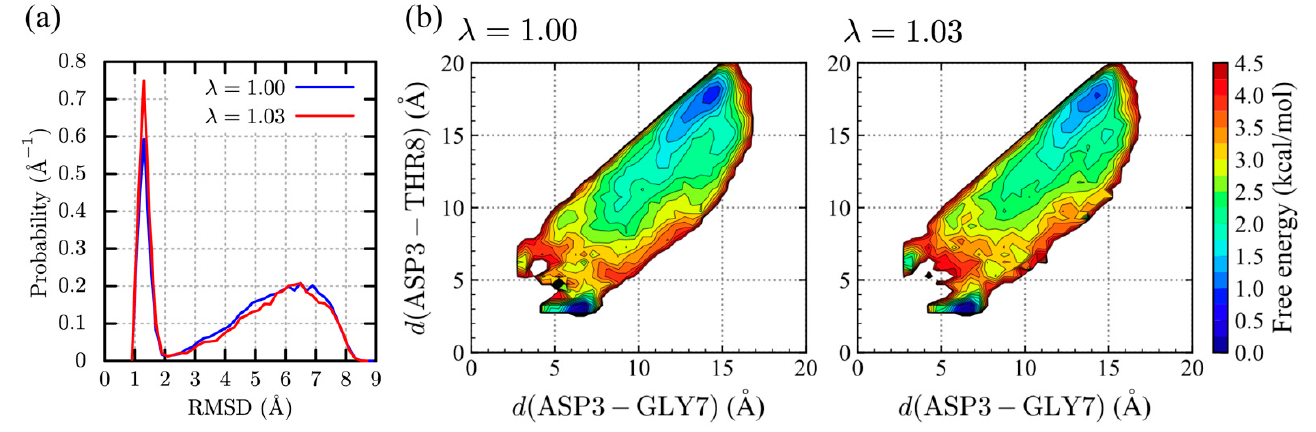
Figure 3. Distributions for the chignolin conformation. ( a ) Probability densities along the C α -RMSD. ( b ) 2D-PMFs spanned with the ASP3-GLY7 and ASP3-THR8 distances for λ = 1.00 ( left ) and 1.03 ( right ).